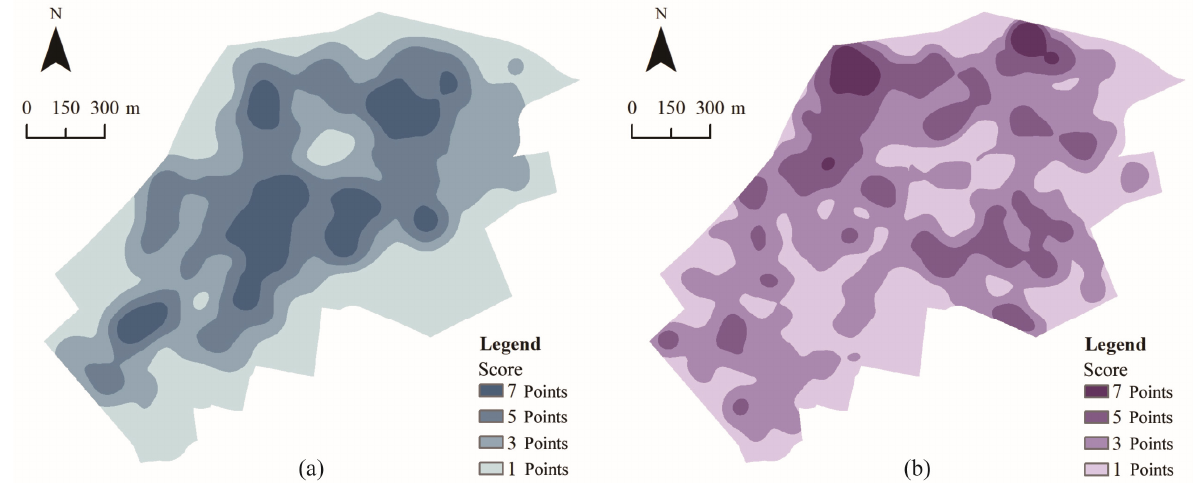
Figure 6. ( a ) Kernel Density of historic-building-based sensitivity criteria; ( b ) Kernel Density of point of interest (POI)-based sensitivity criteria.